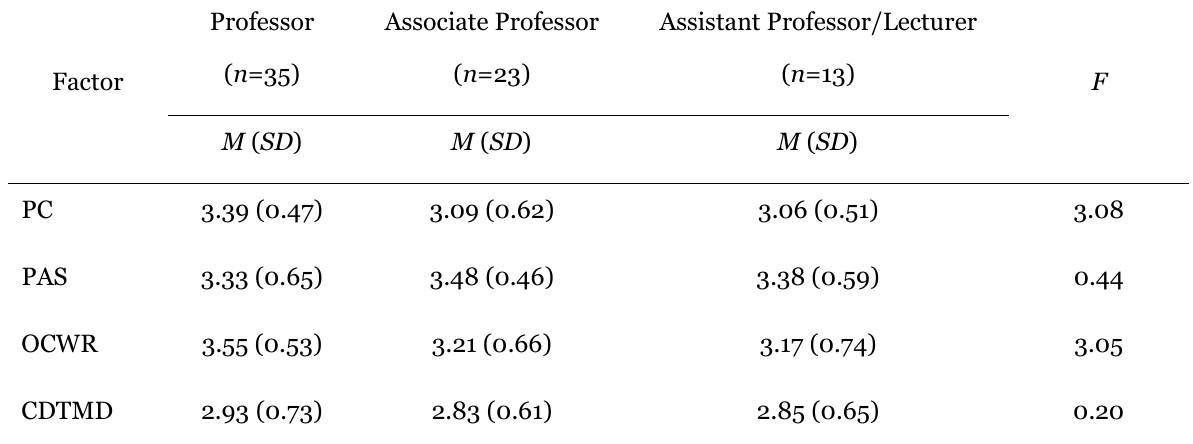
Descriptive Statistics and One-Way ANOVA of OCW-Experienced Faculty Position Relative to TRS-OCW